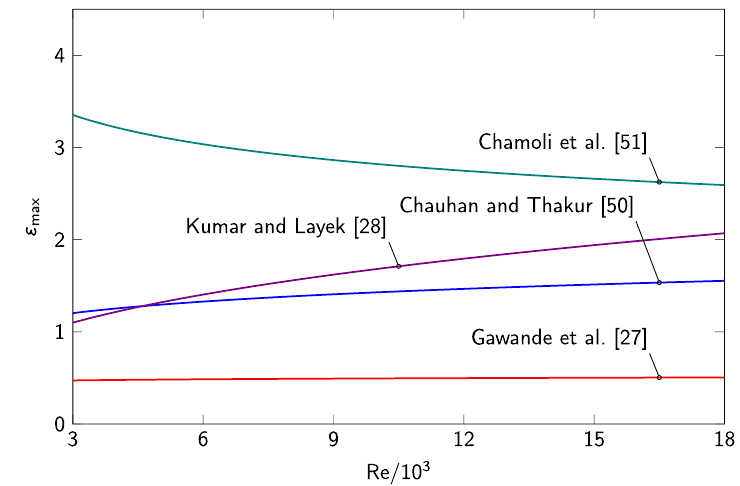
Figure 20. Relationship between ε max and Re for absorber plates with other obstacle